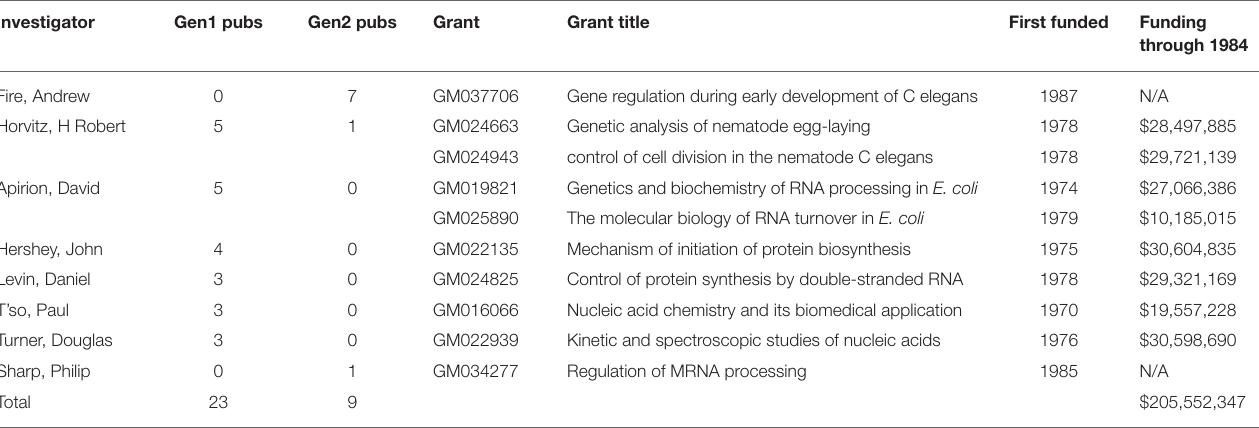
TABLE 4 | NIGMS research grants generating 37 percent of all NIGMS-supported publications associated with Onpattro development.